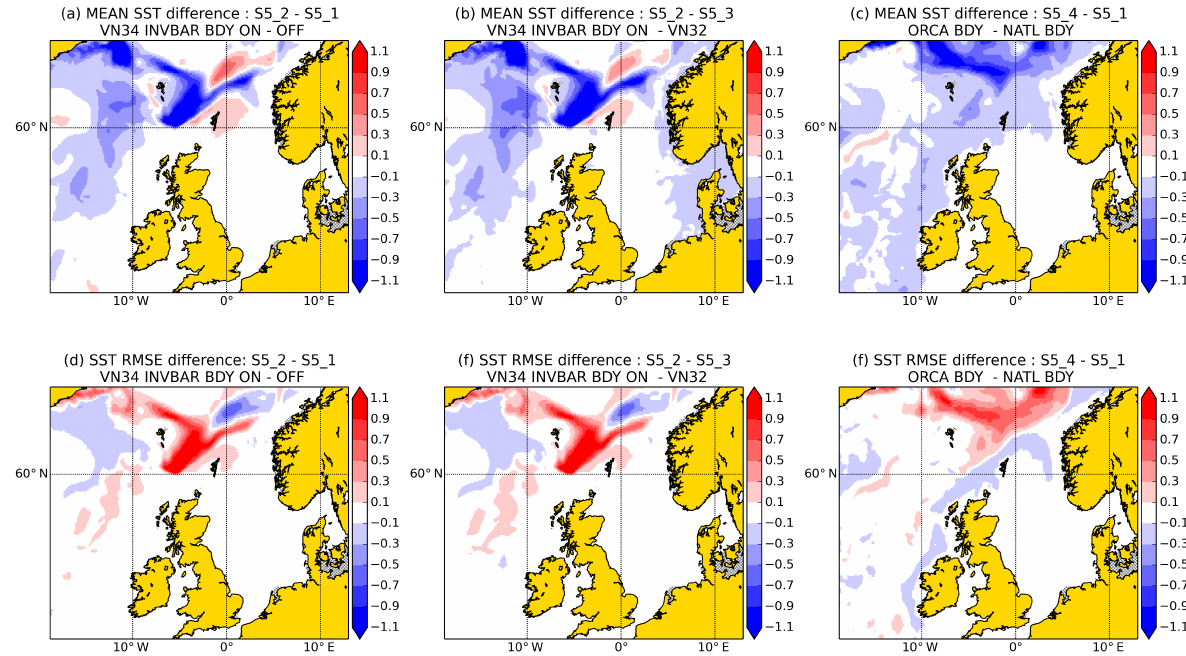
Figure 16. Isolating the difference in northern SST bias between CO4 and CO5. Panel (a) shows the mean SST difference between the NEMO v3.4 with the inverse barometer applied to the boundary and without (S5_2–S5_1). Panel (b) shows the mean SST difference between NEMO v3.4 with the inverse barometer applied to the boundary and NEMO v3.2 (S5_2–S5_3). Panel (c) shows the mean SST difference between NEMO v3.4 with ORCA025 and NATL12 boundary data (S5_4–S5_1). Panel (d) shows the difference between SST RMSE between NEMO v3.4 with the inverse barometer applied to the boundary and without (S5_2–S5_1). Panel (e) shows the difference between SST RMSE between the NEMO v3.4 with the inverse barometer applied to the boundary and NEMO v3.2 (S5_2–S5_3). Panel (f) shows the difference of SST RMSE between NEMO v3.4 with ORCA025 and NATL12 boundary data (S5_4–S5_1).